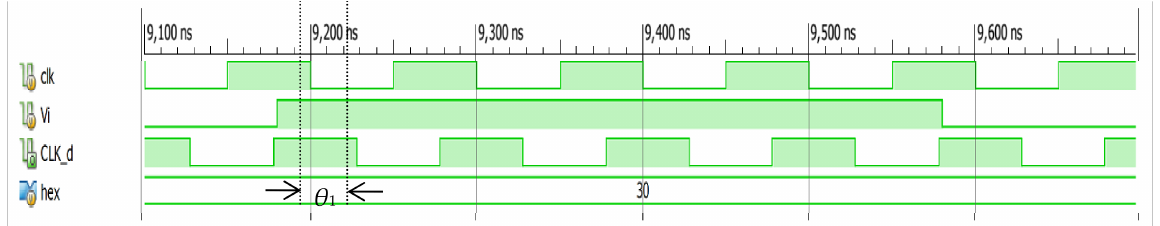
Figure 10. Output result for the detection of θ 1 = 108 ◦ of delay for voltage input Vi .